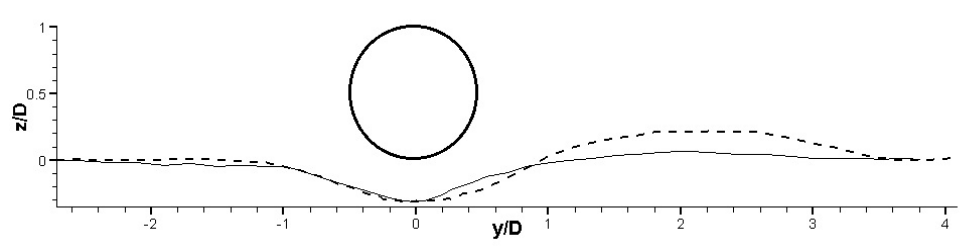
Figure 7. Predicted (dashed line) and measured (solid line) bed profiles beneath sphere, θ ∞ = 0.12 .